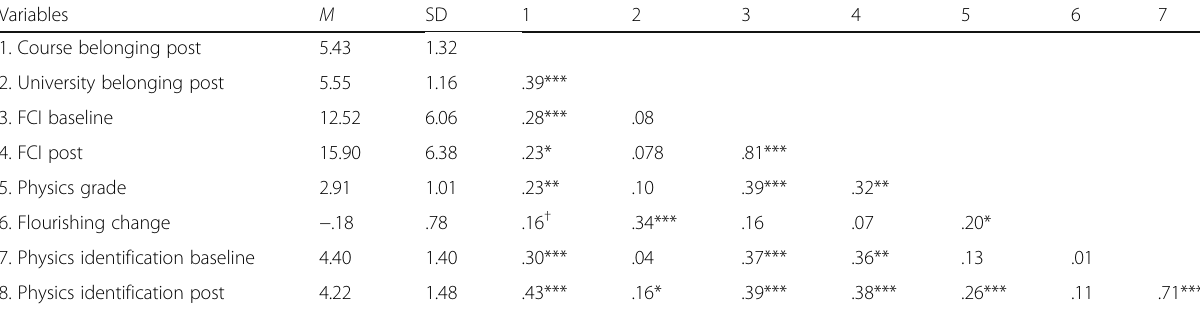
Table 3 Mean scores, standard deviations, and intercorrelations for all continuous variables Variables